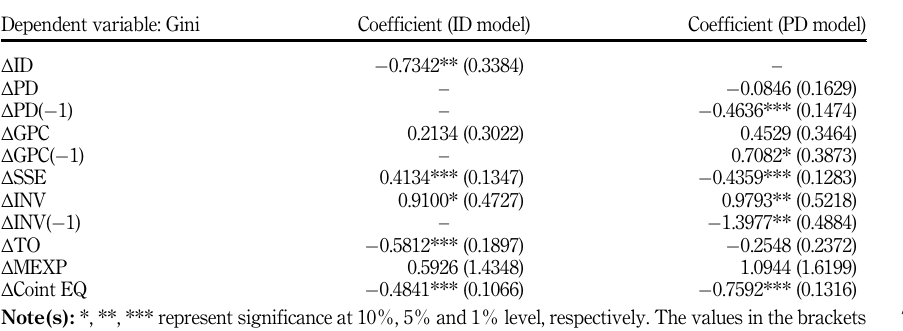
Table 7. The estimates of